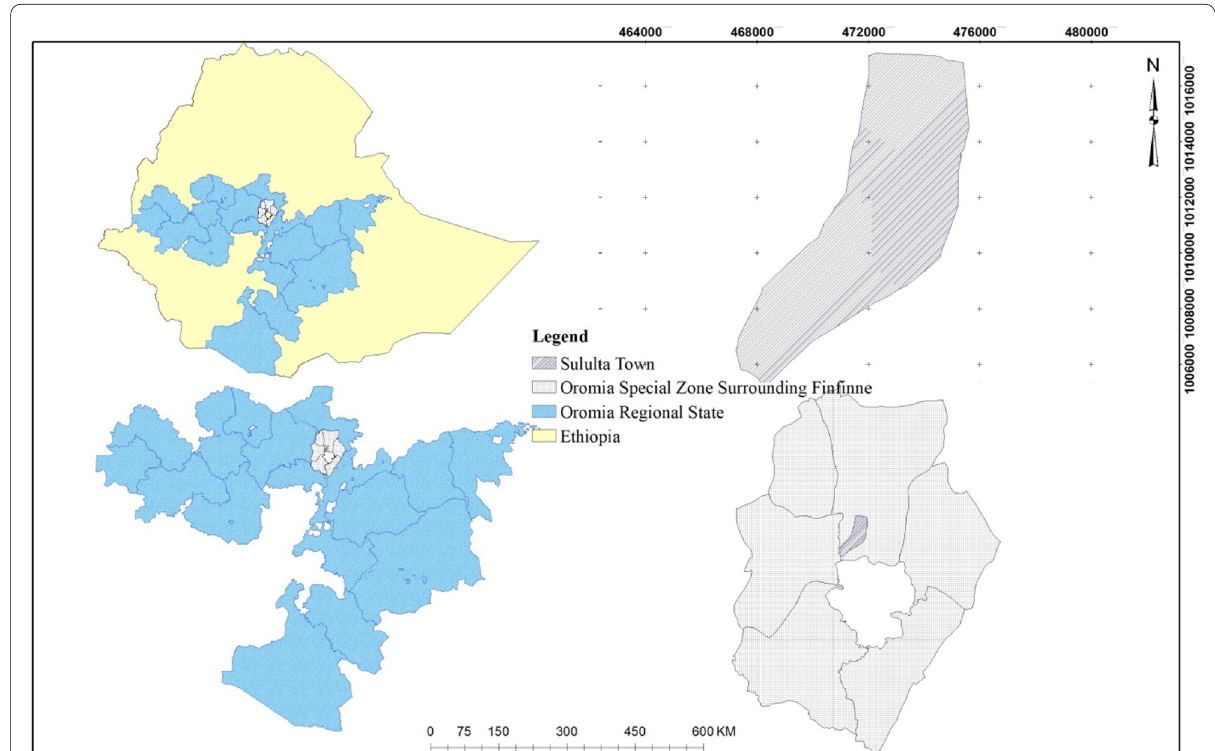
Fig. 1 Map of the study